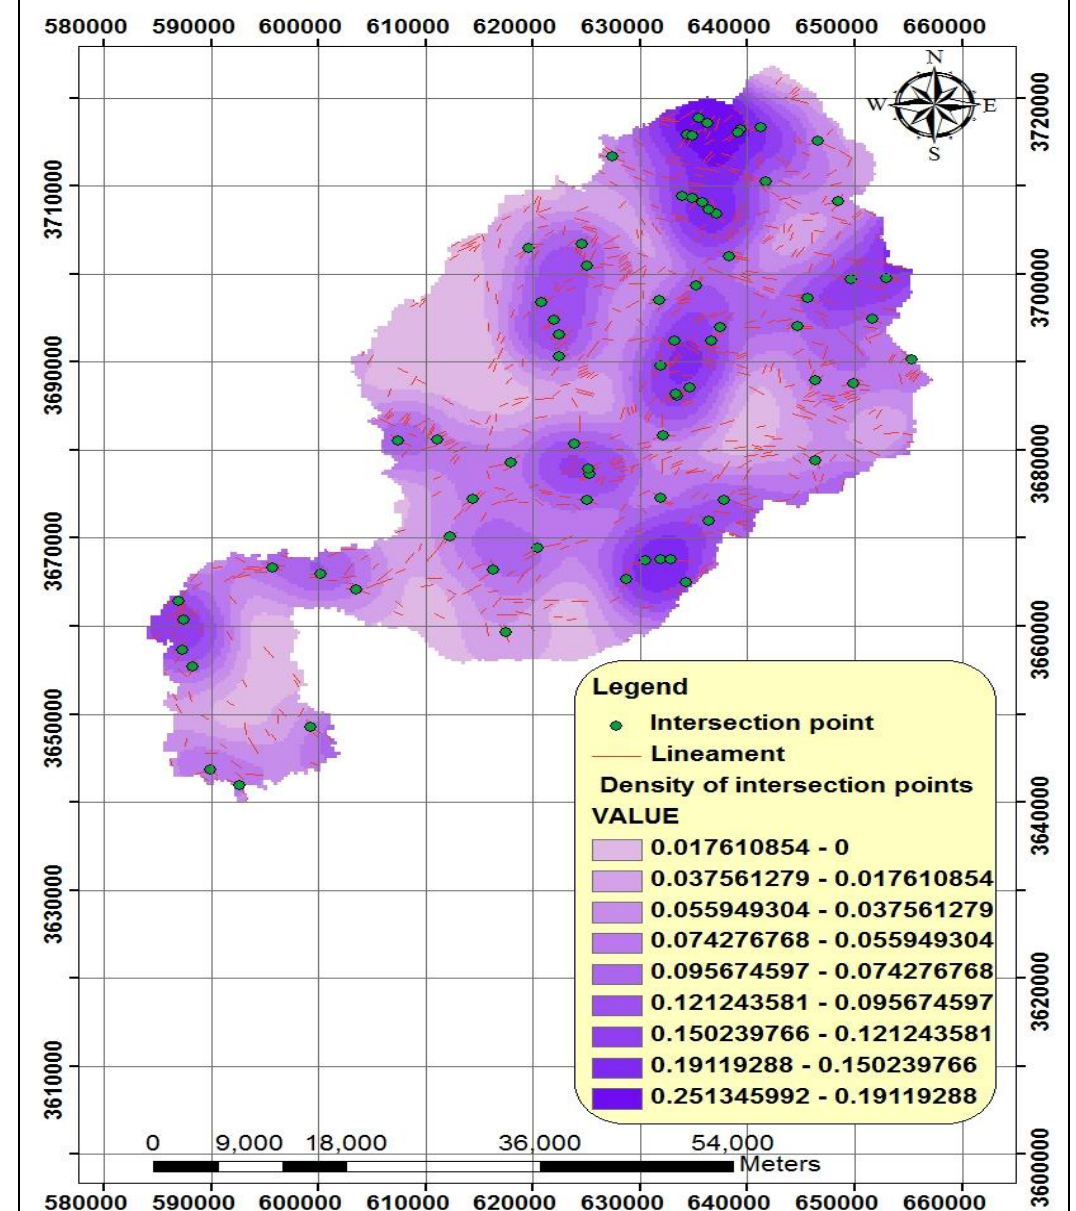
Fig. 5: The lineament intersection density Map by using rc